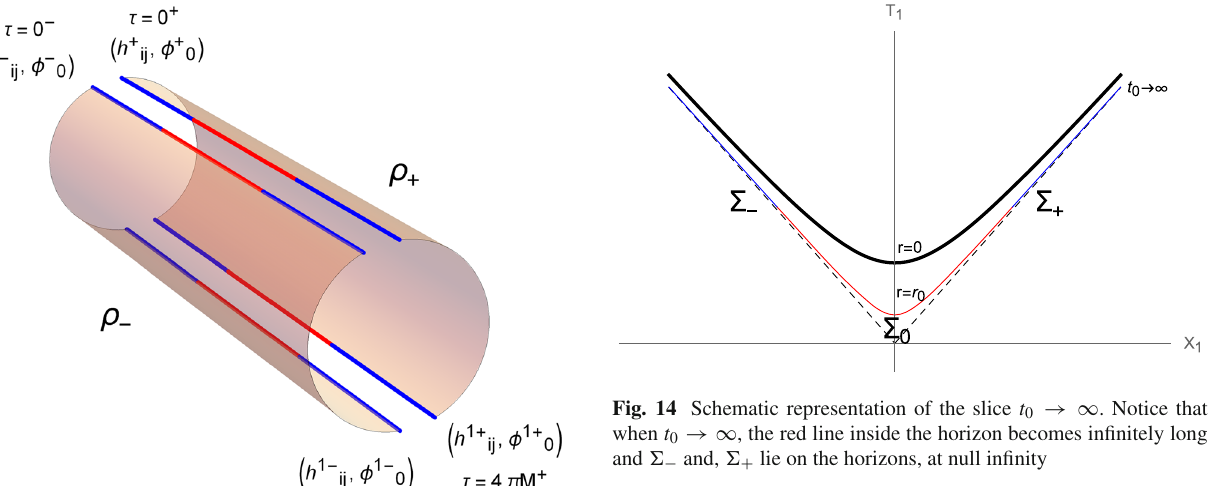
like to stress that g c in (5.2) is the metric we have built in the previous section.